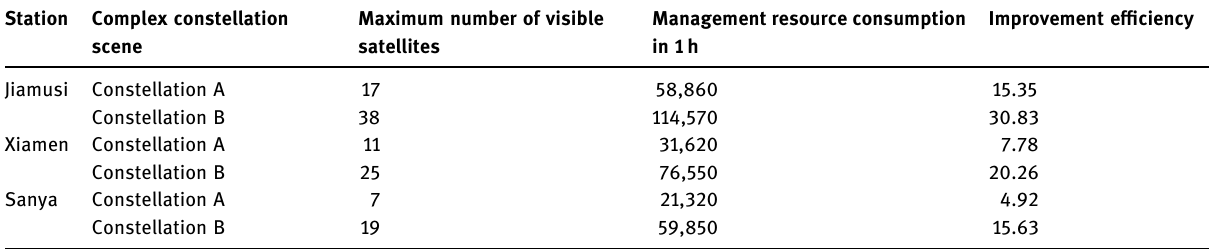
Table 4: Simulation results of the number of visible satellites in di ff erent scenes Station Complex